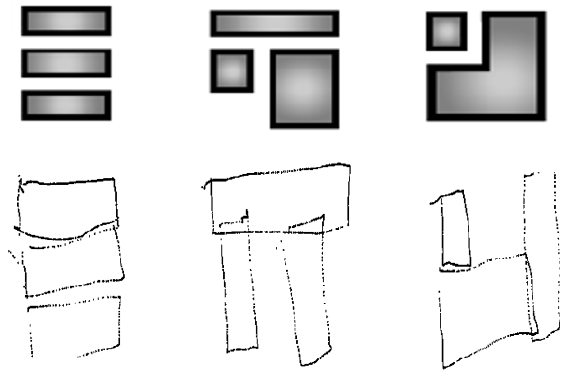
Figure 4. Original shapes and drawings of the perceived visual structures by the